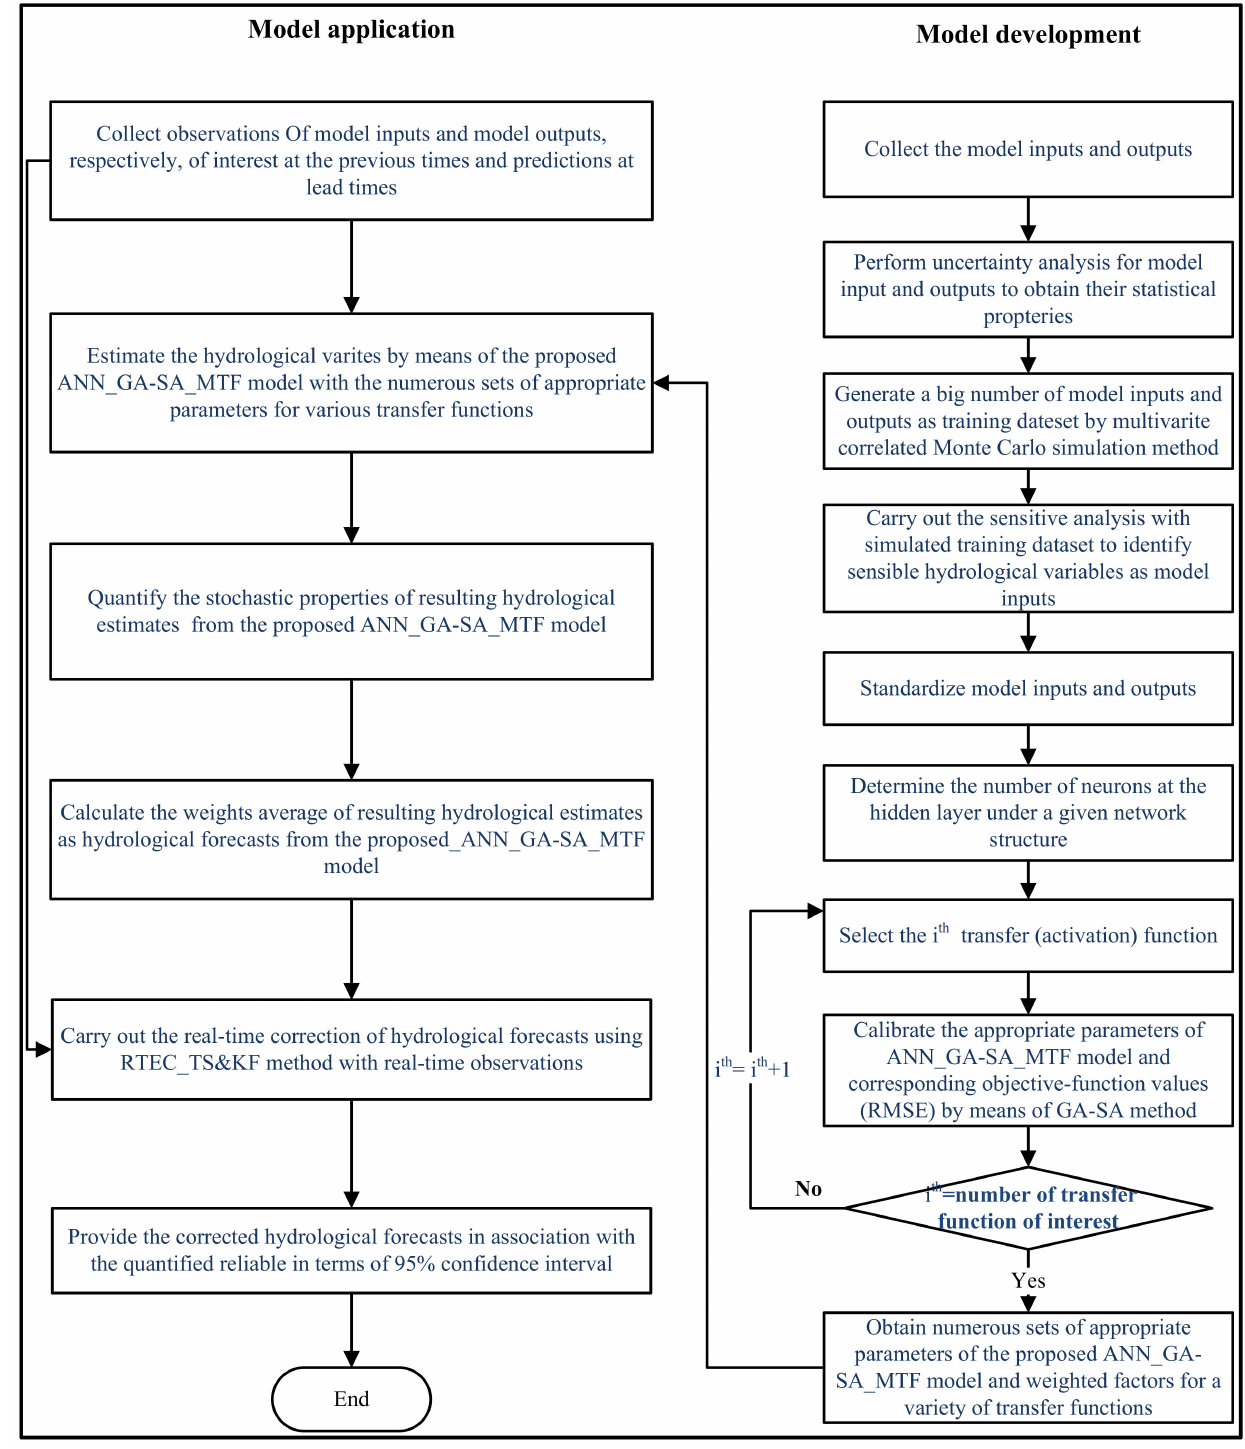
Figure 3. Graphic framework of developing and applying the ANN_GA-SA_MTF model